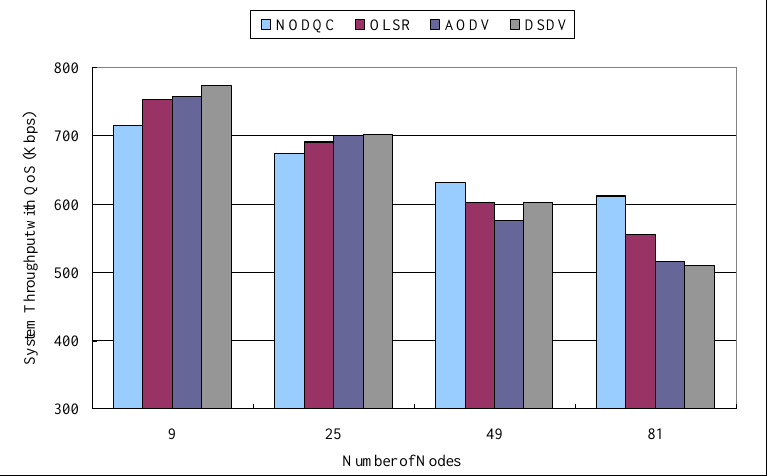
Figure 8. Experiment results of routing algorithms (system throughput with